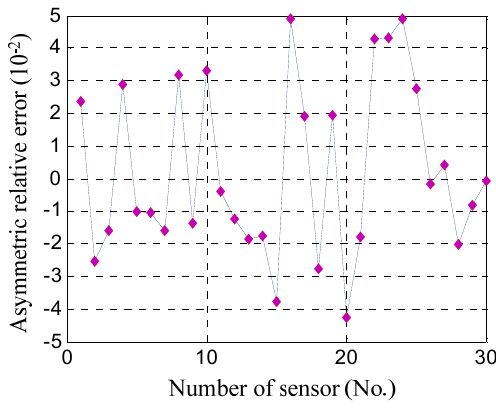
Figure 9. The prediction results of thirty sensors.